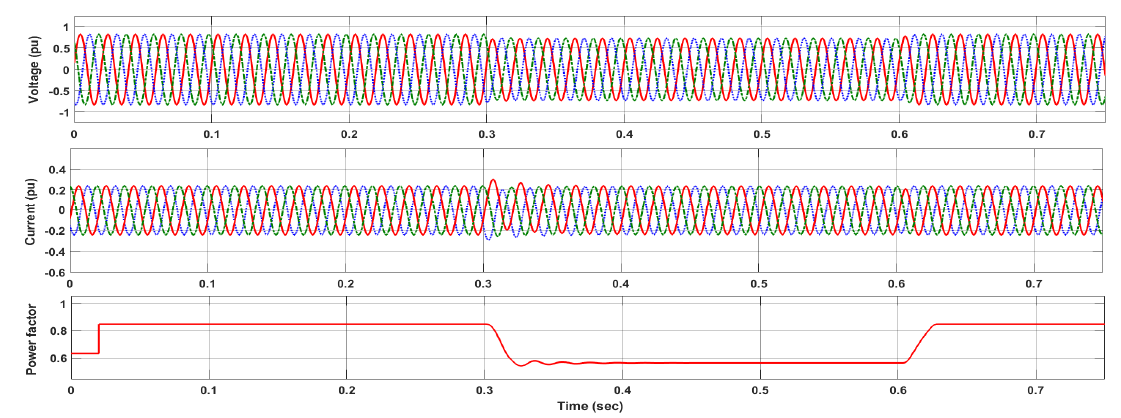
FIG. 10. REAL TIME VOLTAGE, CURRENT, AND POWER FACTOR PLOTS WITHOUT SVC (UN- COMPENSATED)